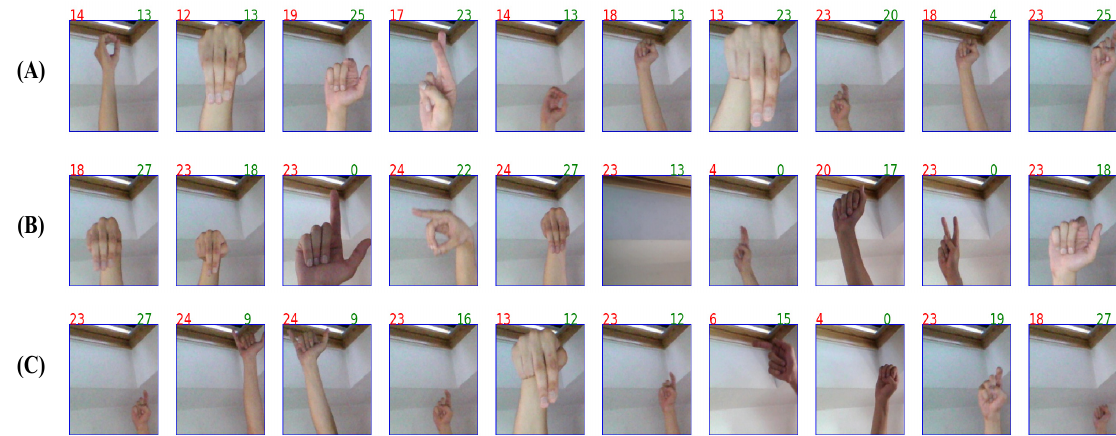
Figure 12. Examples of mis-labeling by all three proposed models; ( A ) original model; ( B ) pruned model; and, ( C ) spatial pyramid pooling